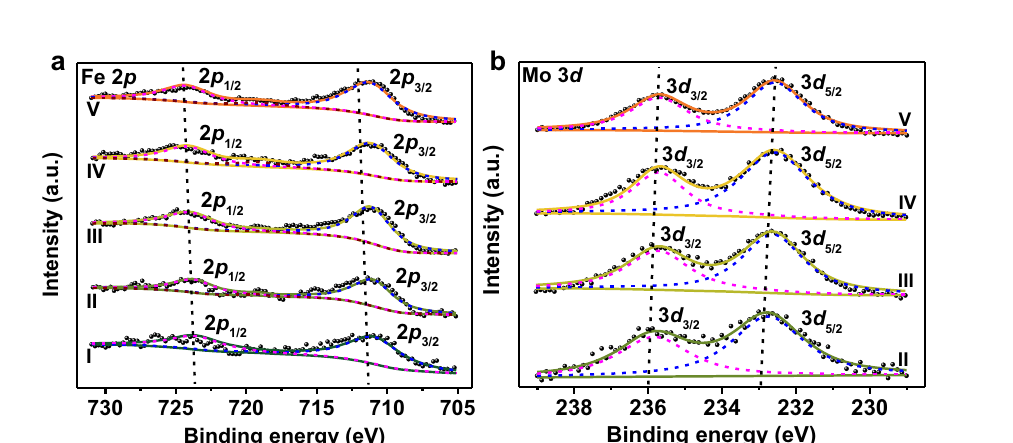
Fig. 3| XPS measurementsofMoO 3 -Fe 2 O 3 redoxcatalysts. XPSspectrafor( a )Fe2 p , ( b ) Mo 3 d of as-prepared redoxcatalysts.I,II, III, IV,and VareforFeAl,1Mo15FeAl, 1Mo12FeAl, 1Mo9FeAl, and 1Mo6FeAl, respectively. The a.u. stands for arbitrary units.